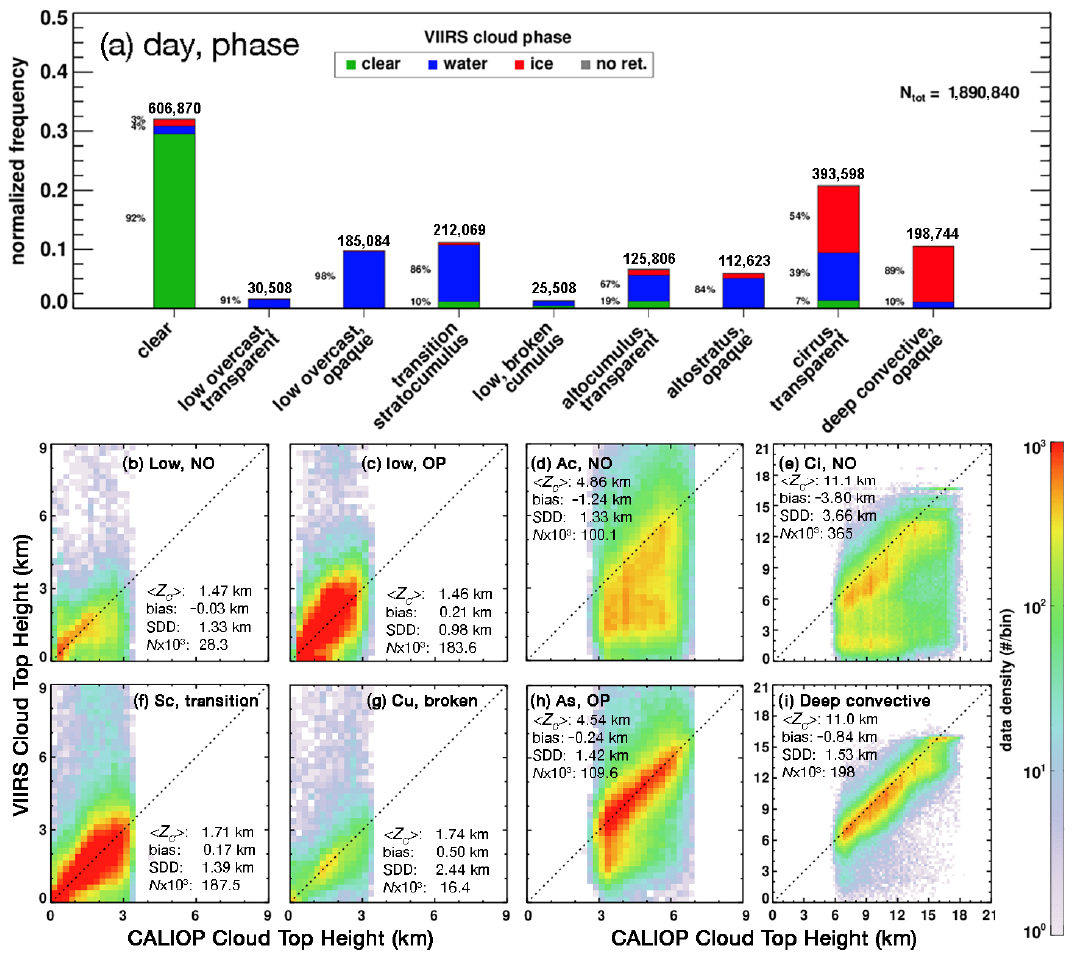
Figure 18. ( a ) CV1S daytime cloud phase selection for different CALIOP cloud types and ( b – i ) scatterplots of 0/100 CTH C and CTH V pairs for each cloud type. Data are from JAJO 2015–2016 and were constrained to CALIOP/CV1S observation time differences of | ∆ t | ≤ 15 min. CALIOP HA ≤ 5 km.